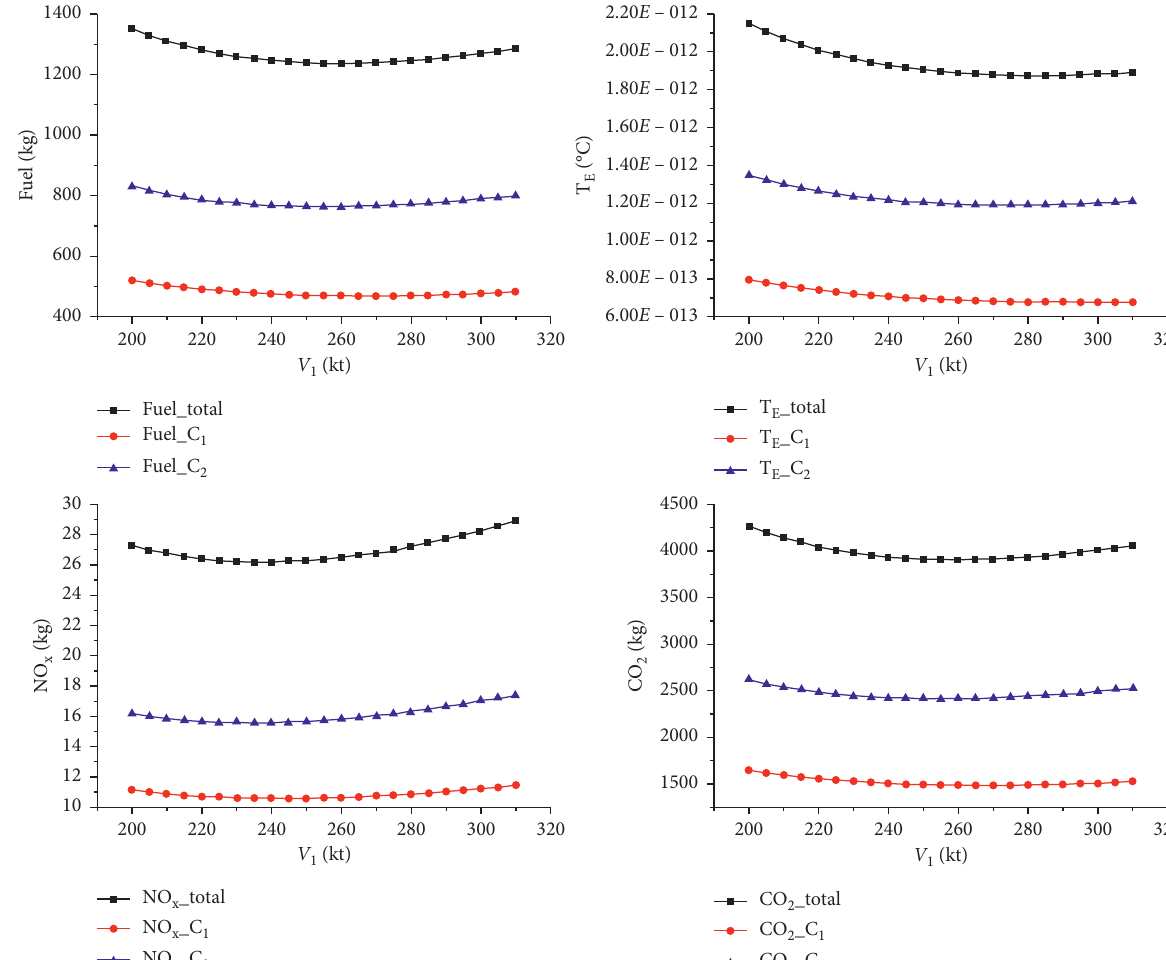
Figure 4: The impact of speed changes on optimization goals and